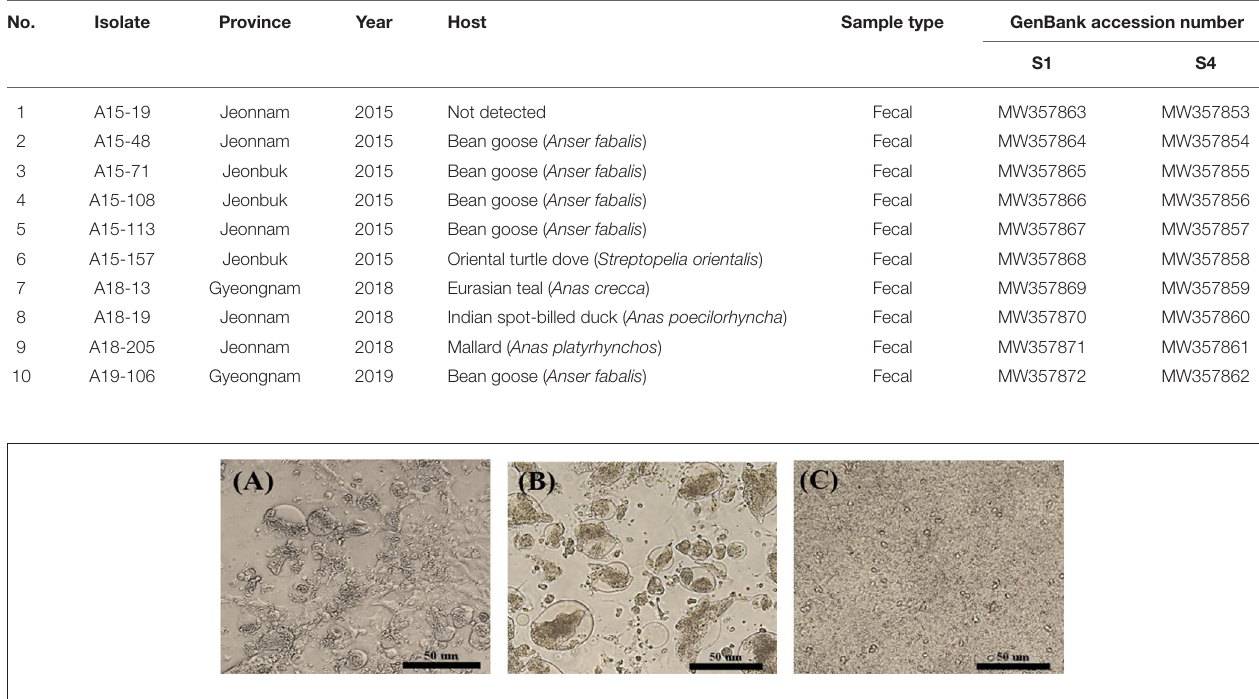
FIGURE 1 | Cytopathic effect (CPE) in ARV-infected CEL cells. (A) S1133/Chicken/USA/1971 infected CEL cells forming a syncytial cluster at 1 day post infection. (B) Representative wild bird isolate (A18-13/Wild bird/Korea/2018) infected CEL cells forming a syncytial cluster at 1 day post infection. (C) Non-infected CEL cell